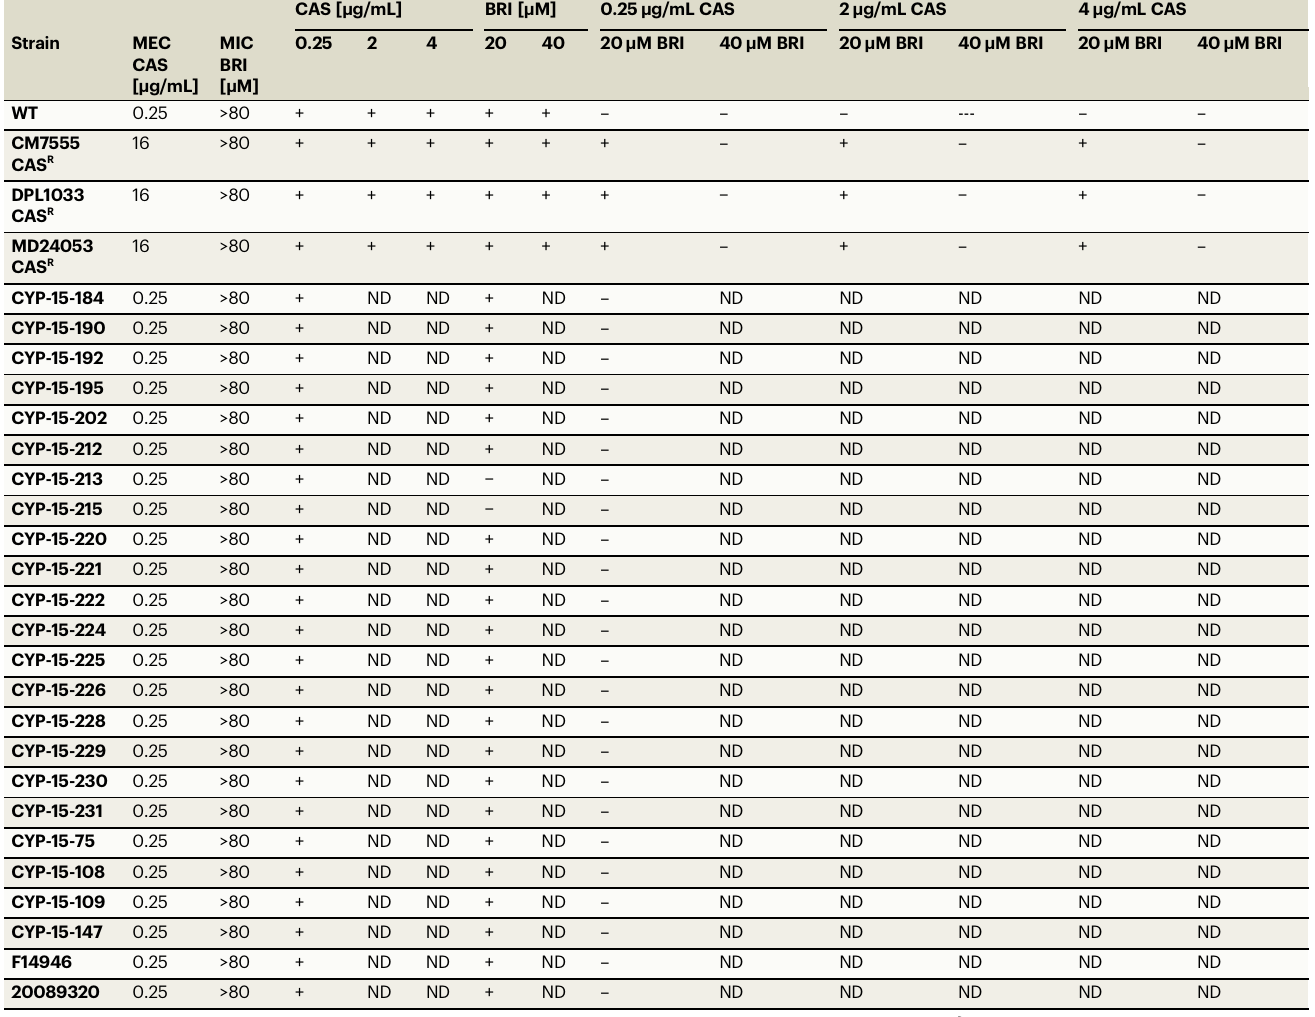
Table 1 | BRI+CAS can overcome A. fumigatus